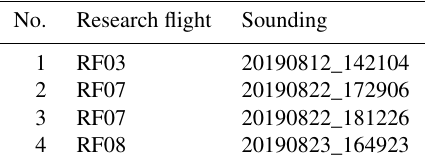
Table 7. Partial fast fall and altitude of normal parachute perfor- mance.